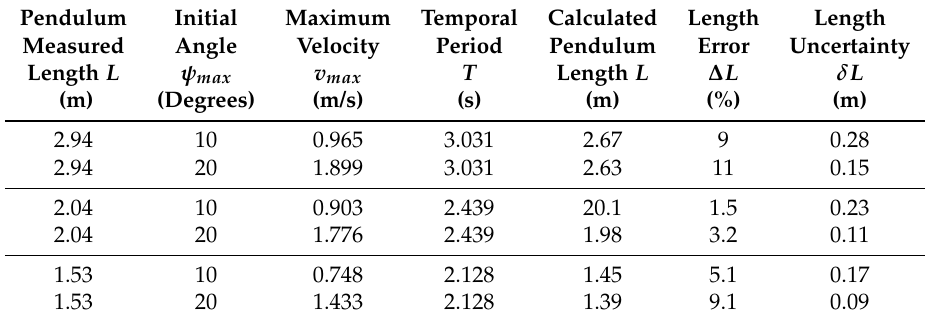
Table 1. The results of the pendulum length estimation obtained from the physical pendulum